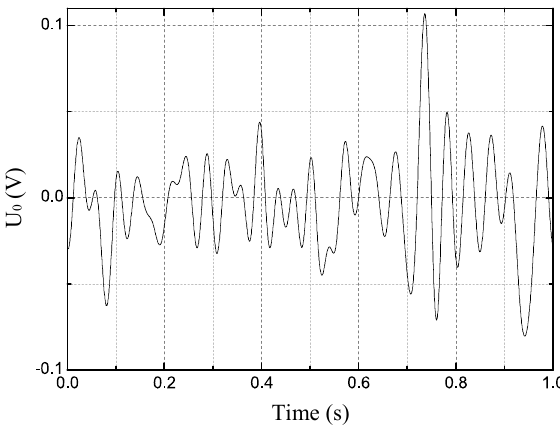
Figure 17. Zero-sequence voltage low-pass filtered waveform.